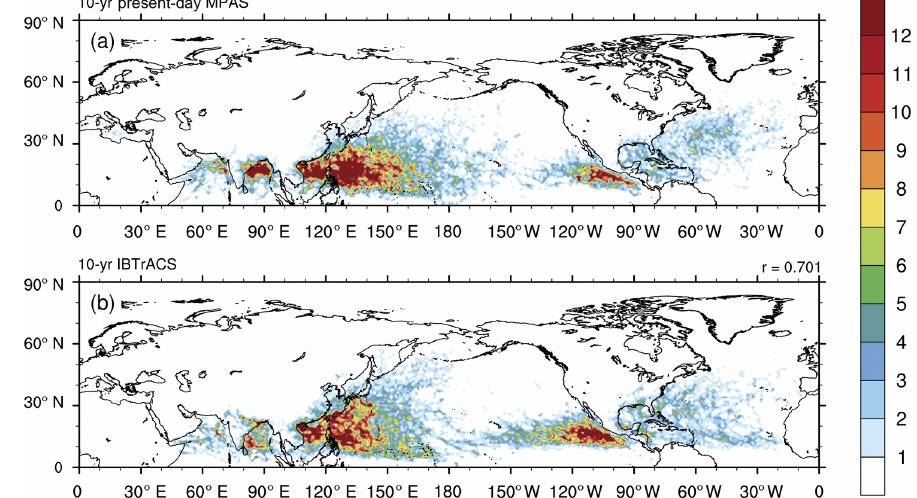
Figure 9. Track density (number of cyclone tracks per 1 ◦ × 1 ◦ area) over the 10 simulated years for (a) present-day MPAS-A simulations and (b) IBTrACS. Contours are shaded every one count.